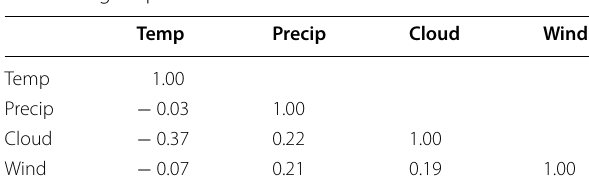
Fig. 3 Maps with mean squared error skill score (MSESS). Models for hourly motorbike and car counts with (MET) are compared to models without (NO_MET) meteorological predictor variables at highway and federal road stations. Positive MSESS values indicate an improvement of the model by including meteorological parameters correlations between different meteorological